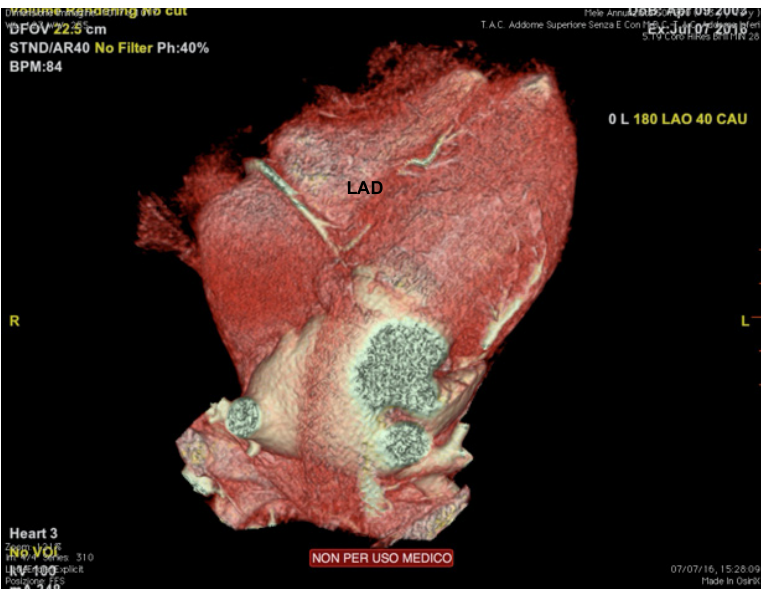
Figure 6. Cardiac computed tomography of an endurance athlete (runner) symptomatic for syncope. The figure shows an intramural course of the left anterior descending coronary artery. LAD: left anterior descending.